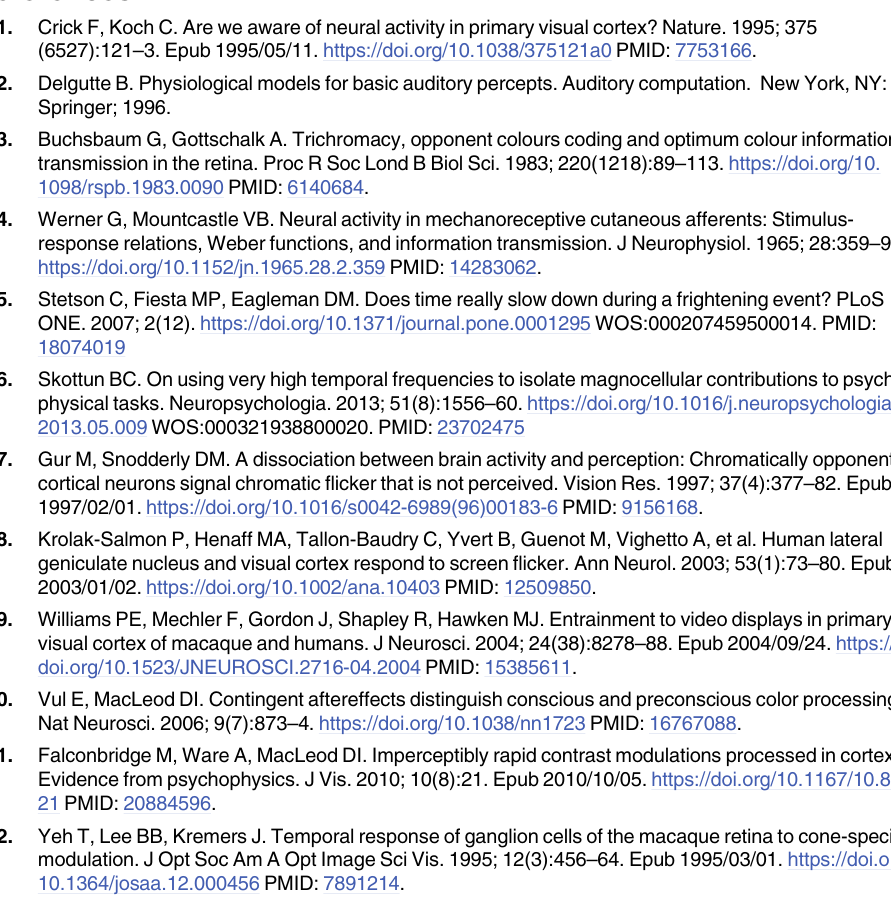
(circles) retinae from Derrington and Lennie [53]. The solid line is a least-squares fit. Parvocel- lular RF sizes were estimated from the model proposed by Watson [81] and shifted down by a factor of 0.8 to account for the smaller RF sizes of macaques [82] (dashed curve). (B) Number of LGN neurons assumed in each ideal observer pool as a function of eccentricity. Pool sizes were calculated on the basis of RF size, the assumption of a hexagonal RF lattice, and the reti- nal size of the stimulus (a Gabor with 0.15˚ SD envelope, truncated at ± 2 SDs). Open circles represent magnocellular neurons and closed symbols represent parvocellular neurons. Circles and triangles represent neurons from monkeys 1 and 2, respectively. Data are available at https://github.com/horwitzlab/LGN-temporal-contrast-sensitivity/blob/master/DataByFigure. xlsx. LGN, lateral geniculate nucleus; RF, receptive field; SD, standard